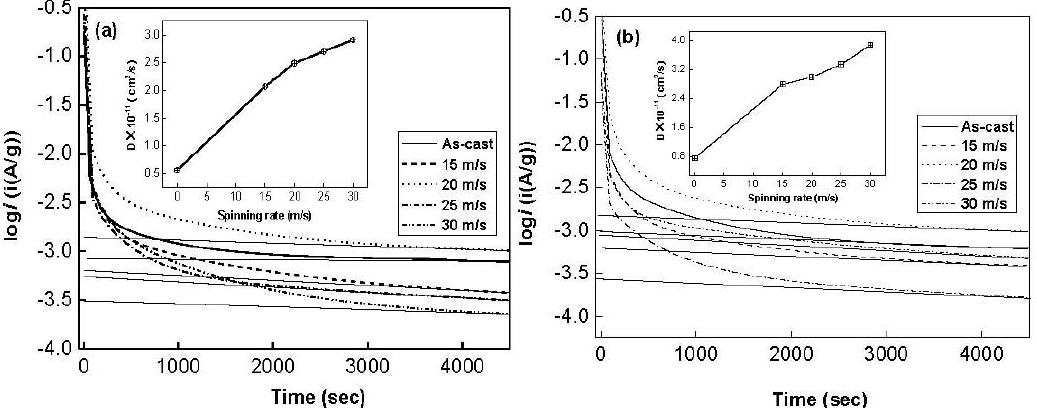
Figure 6. Semilogarithmic curves of anodic current vs. time responses of the alloys: ( a ) Co alloy; ( b ) Co 0.1 0.4